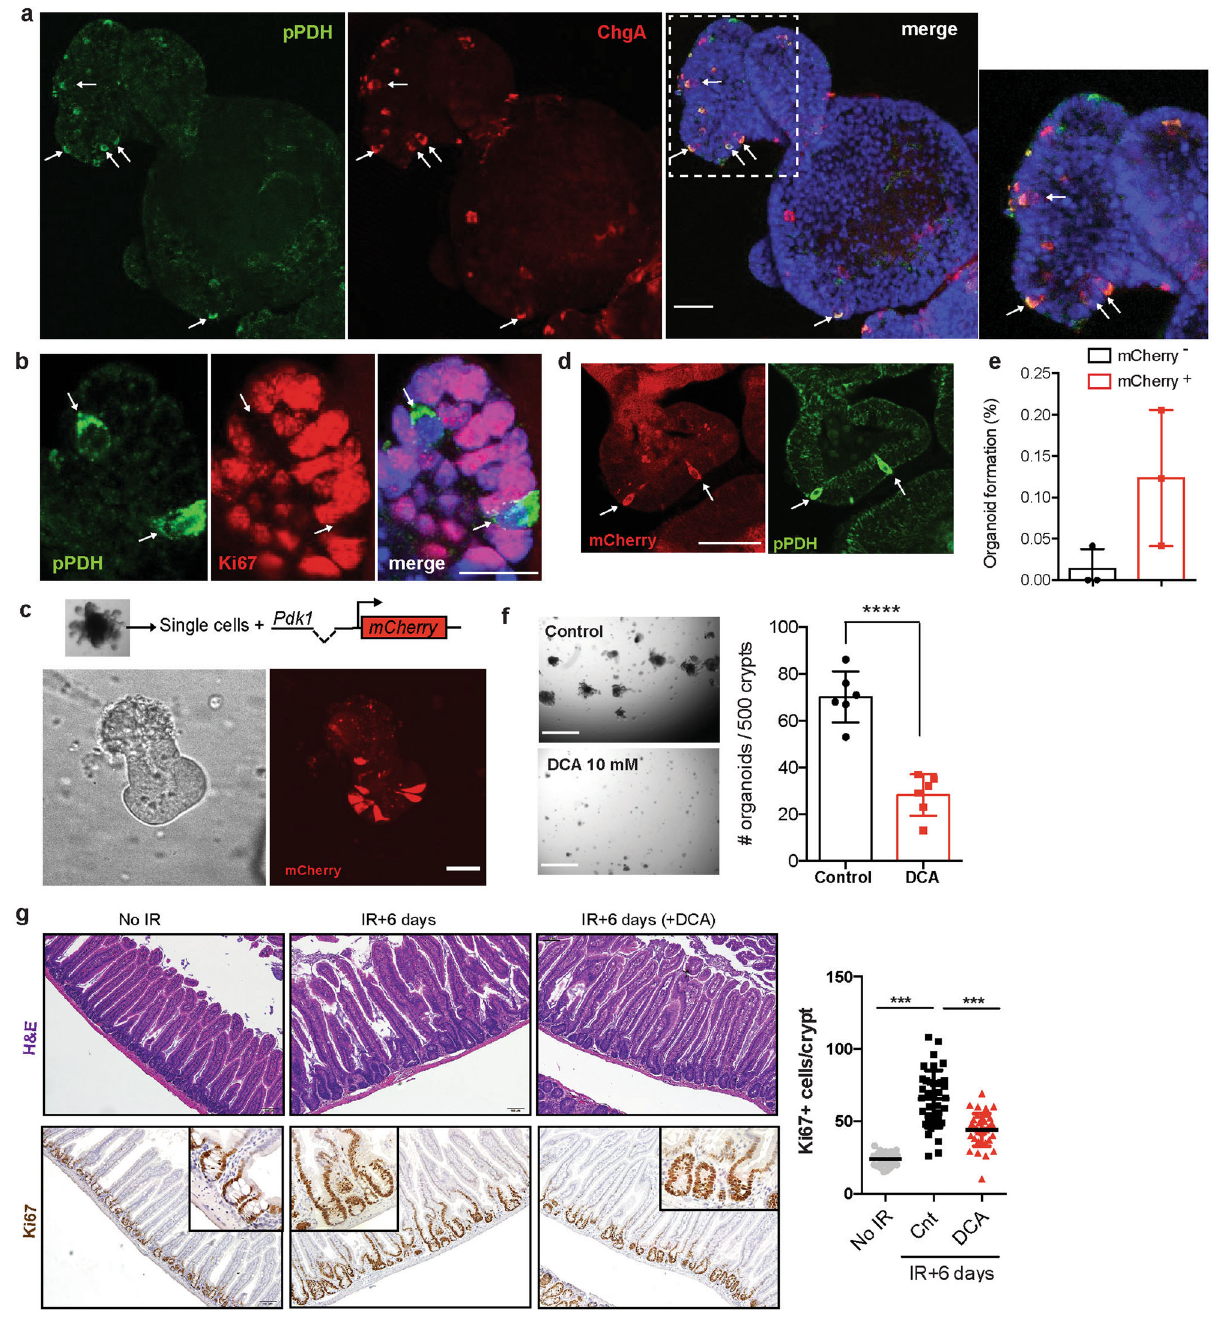
Fig. 3 High glycolysis supports stem cell potential of pPDH + intestinal epithelial cells. a Immuno fl uorescence of pPDH and ChgA in small intestinal organoids. Notice that most cells are pPDH + ChgA + (arrows). The experiment was repeated four times with similar results. Scale bar, 25 μ m. b Immuno fl uorescence of pPDH and Ki67 in intestinal organoids. The experiment was done four times with similar results. Scale bar, 20 μ m. c Single cells derived from intestinal organoids were infected with the Pdk1-mCherry reporter. Picture shows a 3-day growing organoid with few crypt cells positive for the reporter (representative image of 10 different experiments). Scale bar, 50 μ m. d Immuno fl uorescence showing co-localization of the mCherry reporter and pPDH (representative image of three independent experiments is shown). Scale bar, 50 μ m. e FACS-sorted mCherry − and mCherry + cells were plated in matrigel and cultured in ENR medium. Organoids were counted 7 days after plating ( n = 3 independent sorting experiments). Data are presented as mean±SD. f Intestinal crypts were grown in ENR medium in the absence of presence of DCA and organoids counted at day 7 ( n = 6 technical replicates). A representative experiment is shown. The experiment was repeated three times with similar results. Data are presented as mean±SD. Two tail t -test was used to determine statistical signi fi cance between groups. Scale bar, 750 μ m. g H&E staining (top) and Ki67 IHC (bottom) of intestinal sections of mice treated or untreated with DCA 6 days post-IR (11Gy). The graph shows the quanti fi cation of Ki67 + cells in the intestines of these mice ( n = 2 mice per condition, at least 30 crypts/mouse were scored). Two tailed t -test (for comparisons between two groups) or one-way ANOVA (for comparisons of more than two groups) were used to determine statistical signi fi cance between groups (* p <0.05; ** p <0.01; *** p <0.001). Source data are provided as a Source Data fi